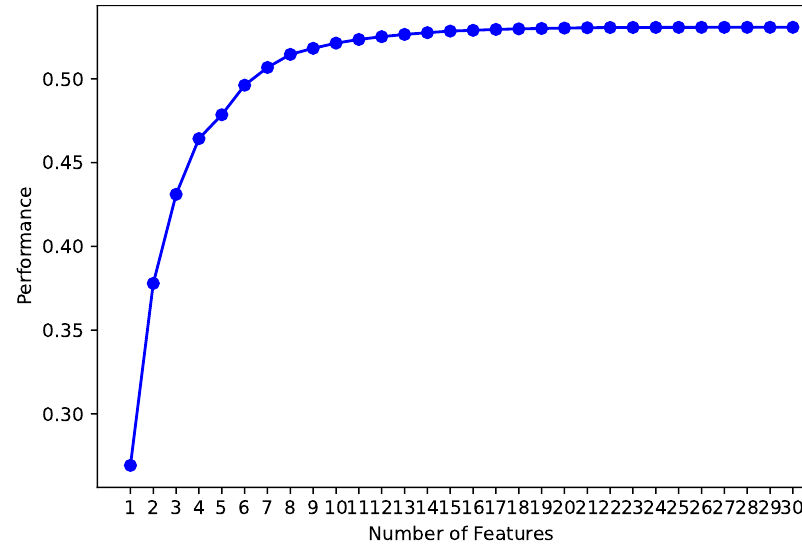
Figure 2. Feature impact on models